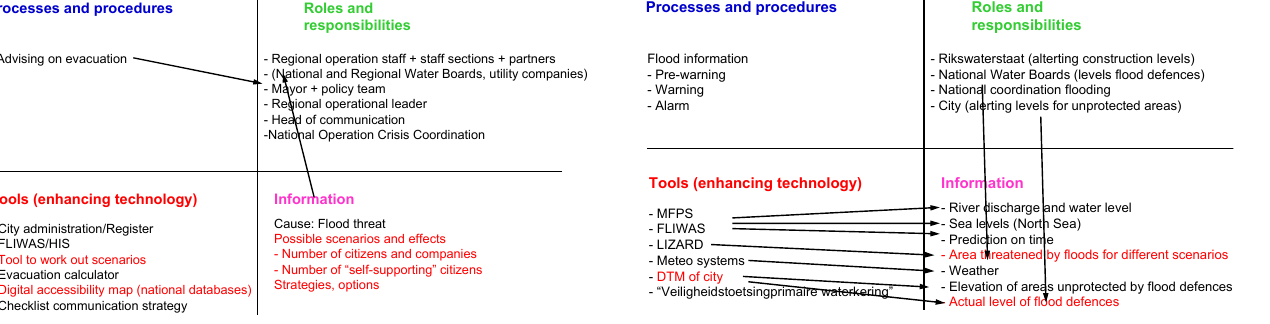
Fig. 11. Cross-table evaluating the process of “advising the mayor”. Fig. 12. Cross-table evaluating the process “flood